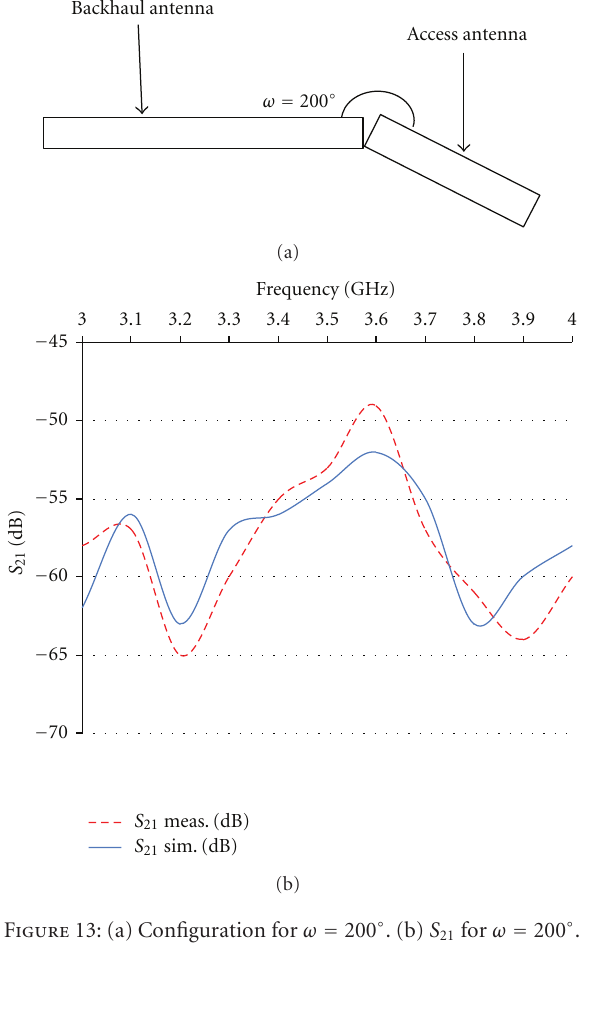
Figure 13: (a) Configuration for ω = 200 ◦ . (b) S 21 for ω = 200 ◦ .